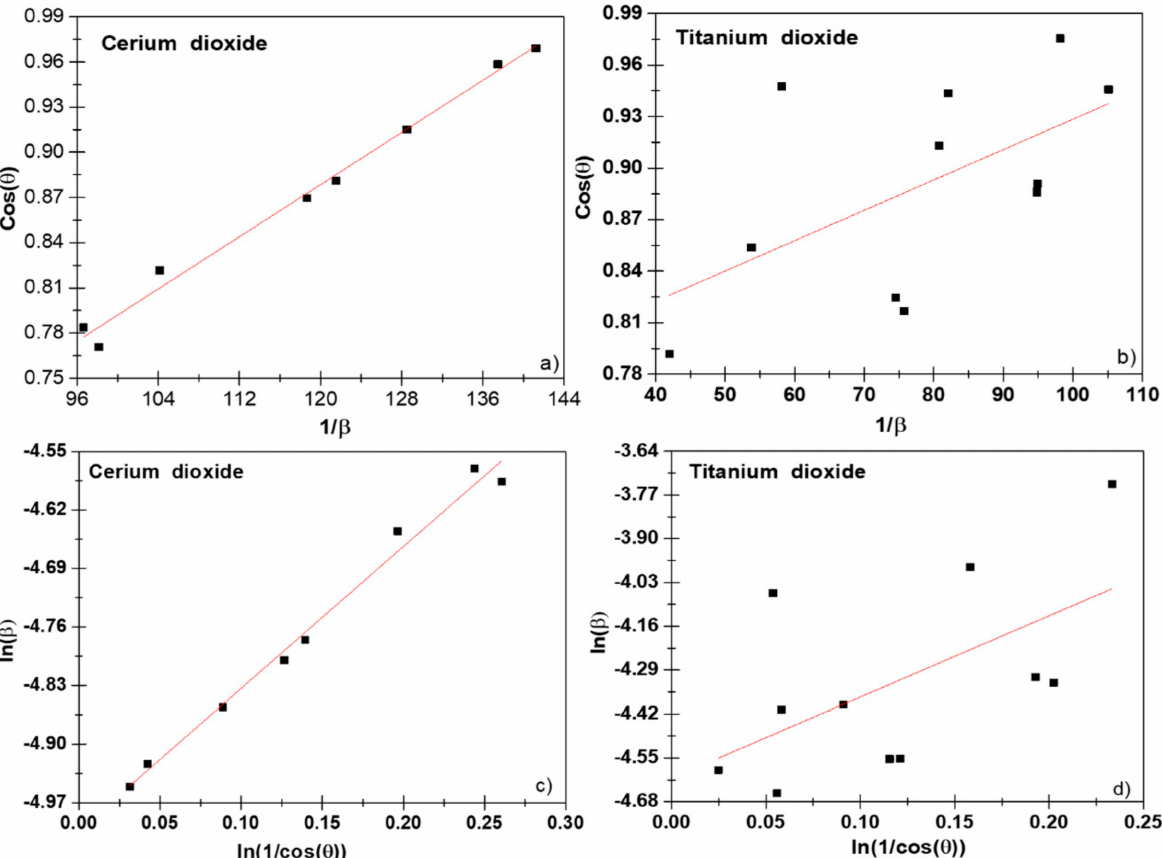
Figure 1. Scherrer plot ( a , b ) and modified Scherrer plot ( c , d ) of CeO 2 and TiO 2